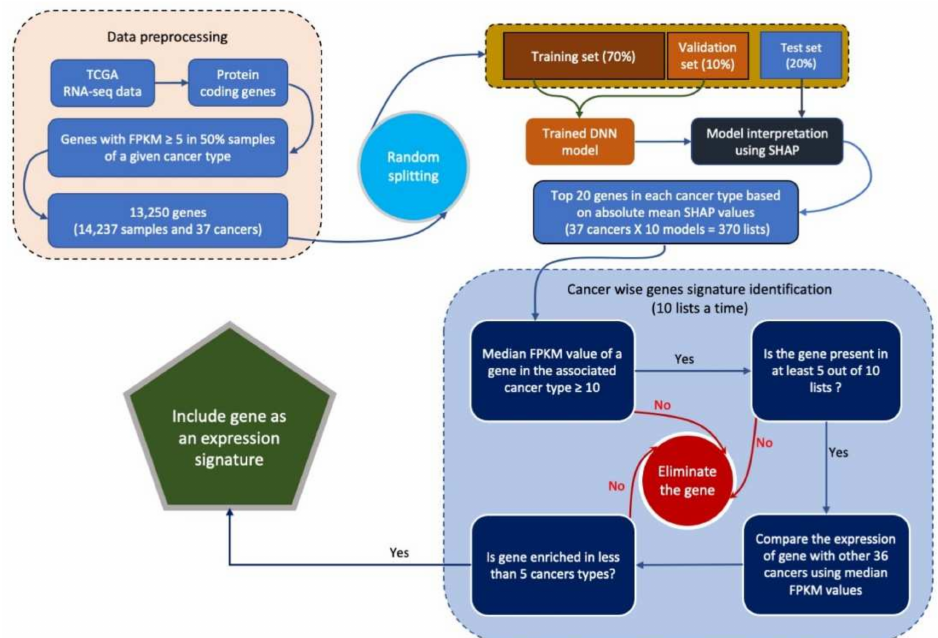
Figure 4. Workflow employed to identify gene expression signatures. A schematic showing workflow employed to identify gene expression signatures using deep learning model and SHAP values.